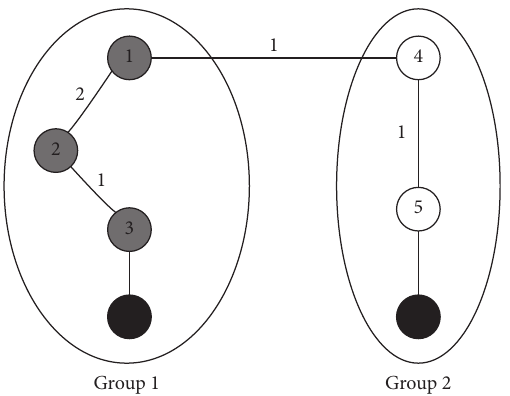
Figure 1: Topology G with two